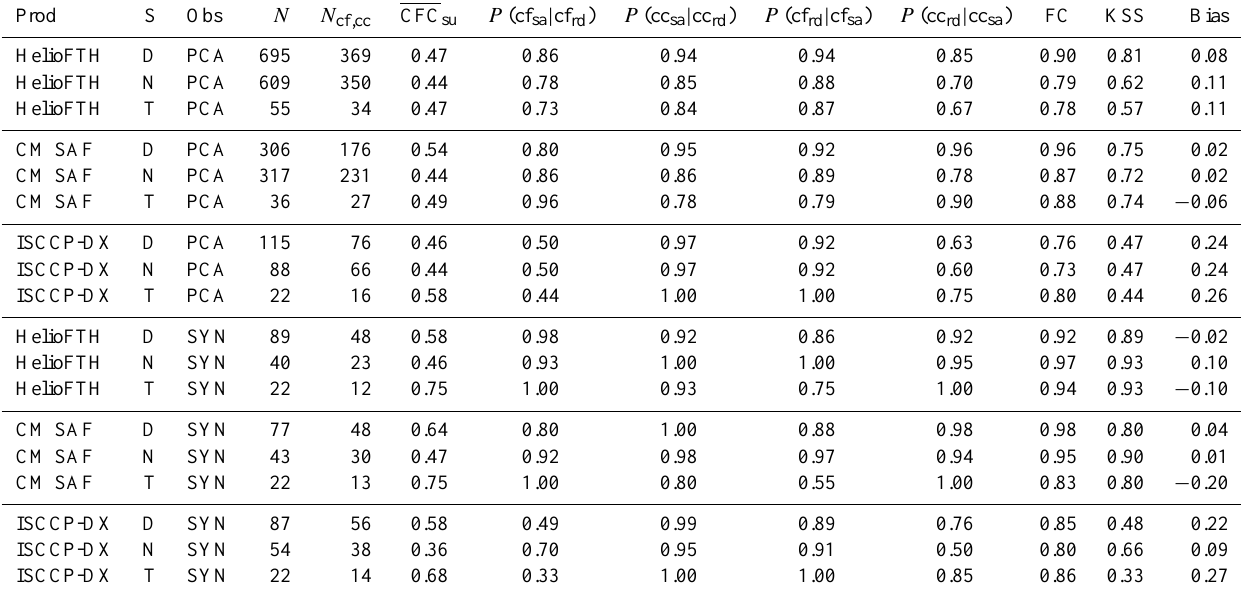
Table 3. Mean results of the comparison of different satellite (sa) products with surface (rd) CFC observations for all investigated sites for April 2004 [Prod = product origin, S=scenario (D=day, N=night, T=twilight), obs = reference cloud observation at the surface (PCA=partial cloud amount, SYN=synop observation), N =number of all available surface values, N cf,cc =number of only